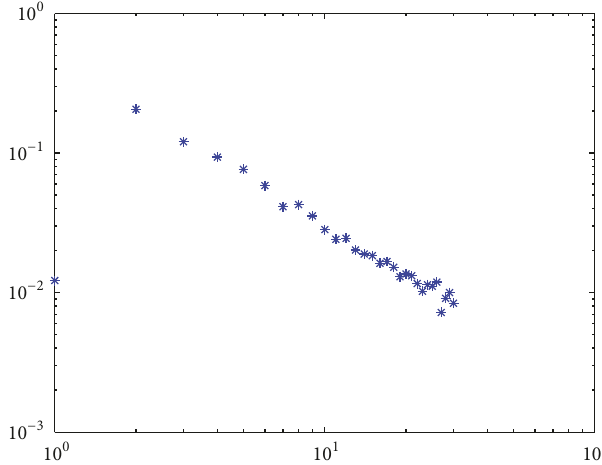
Figure 3: Degree distribution of refined power-law network.